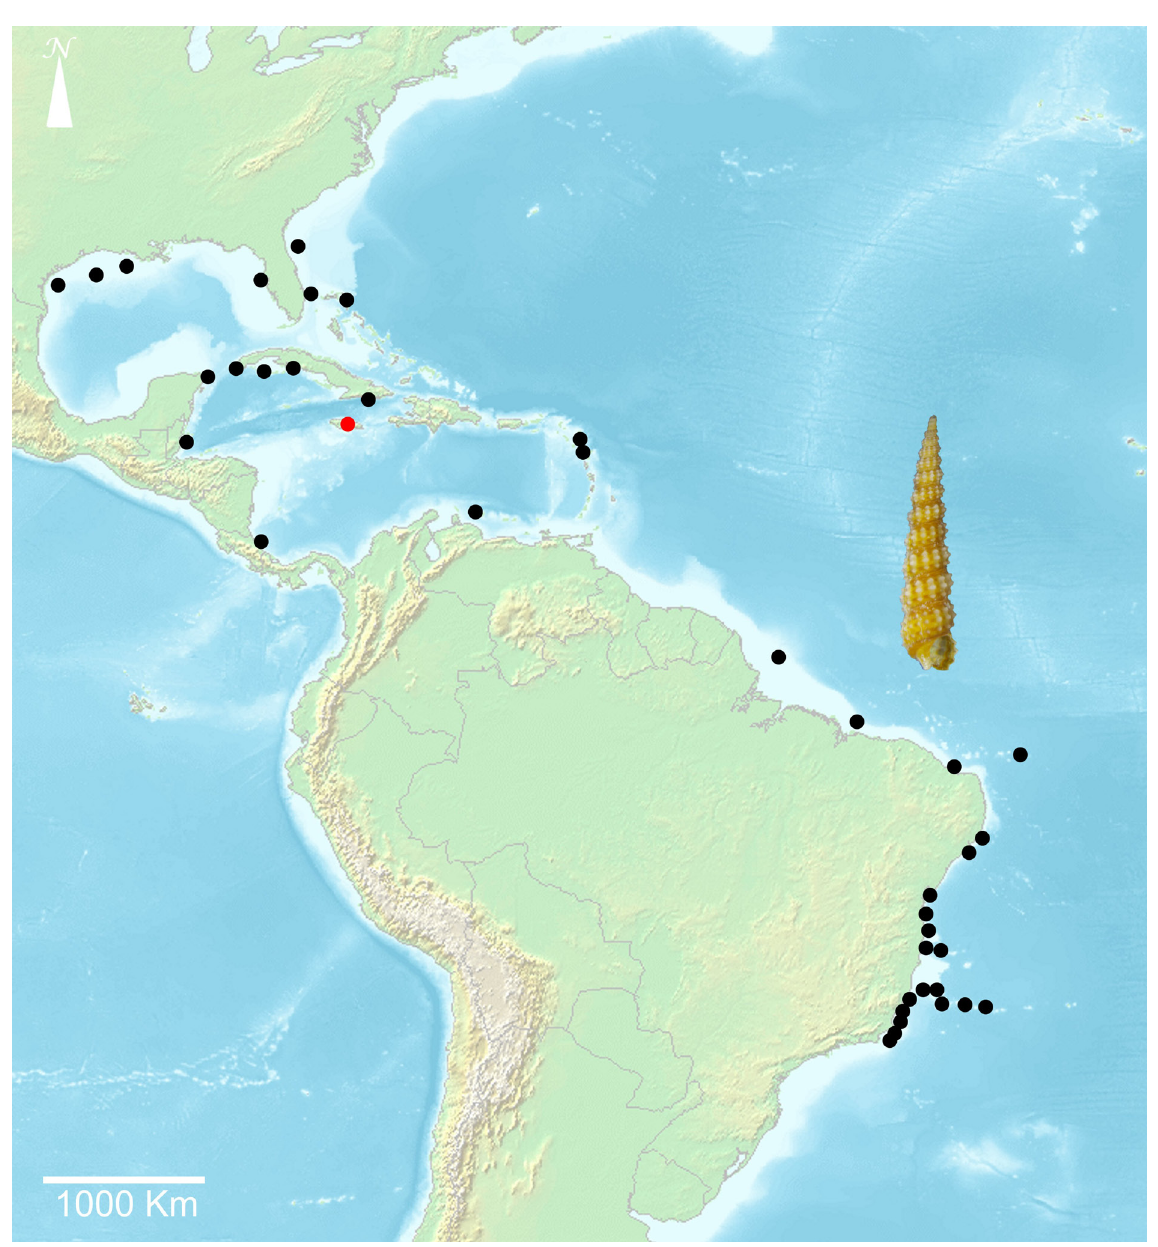
Fig. 25. Distribution map of Metaxia excelsa Faber & Moolenbeek, 1991; red circle = type